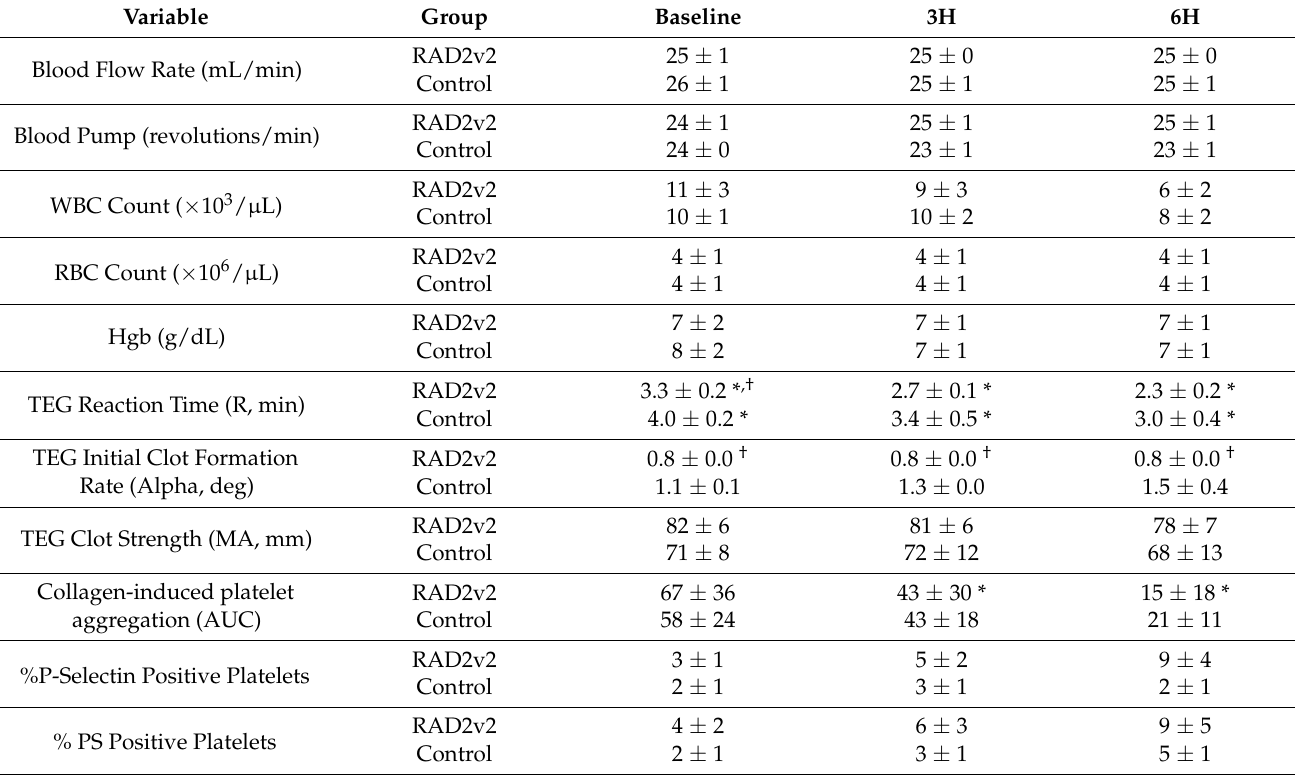
Results are reported as mean ± standard deviation. *: Indicates significant change from Baseline value; † : Represents significant between- group difference. All tests were two-sided with p < 0.05 for significance. WBC, white blood cell; RBC, red blood cell; Hgb, hemoglobin; AUC, area under